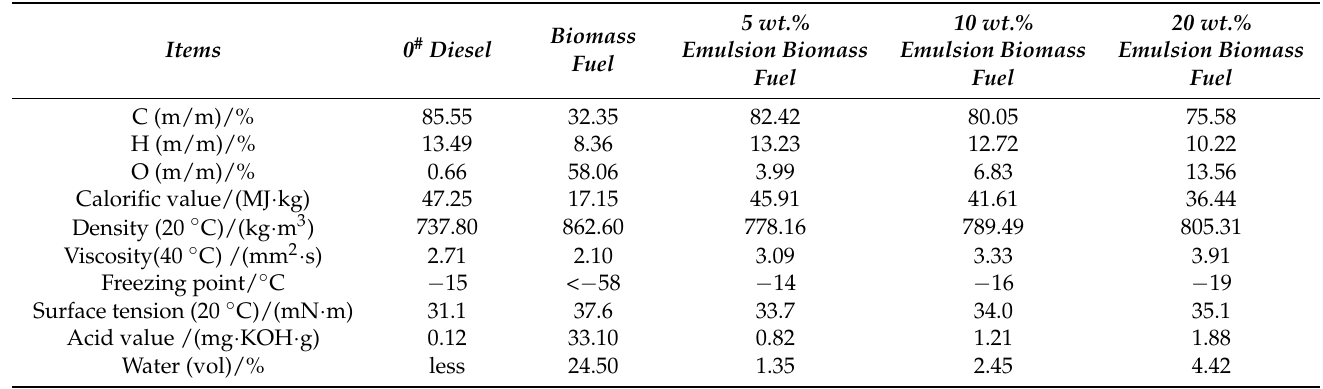
Table 2. Basic performance of varied biomass fast pyrolysis fuel and diesel